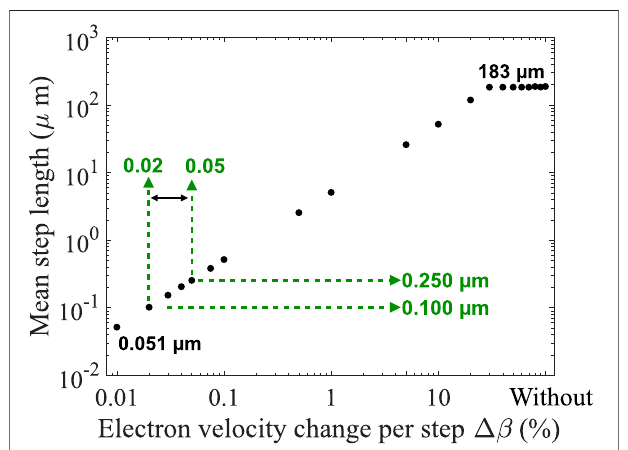
FIGURE 4 | Electron mean step length as a function of the electron velocity variation Δβ , in log-log scale. Shown in green is the Δβ range and correspondingmeansteplengththatbestapproximatetheelectronmeanfree path in BGO.